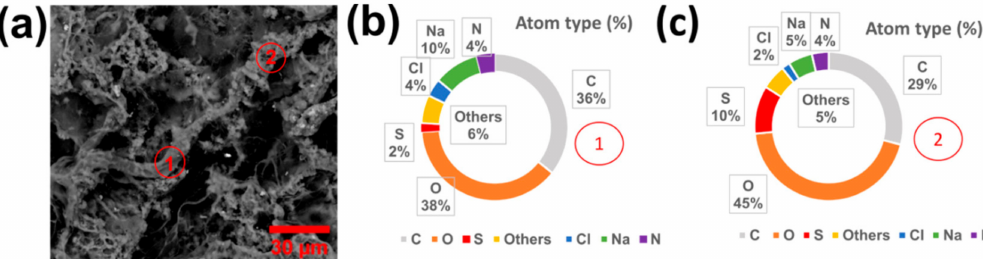
Figure 5. ( a ) Surface SEM micrograph of the PASP/PEDOT hydrogel. EDX analyses determined on ( b ) Point 1 (without PEDOT) and on ( c ) Point 2 (with PEDOT) of the sample displayed in ( a ).